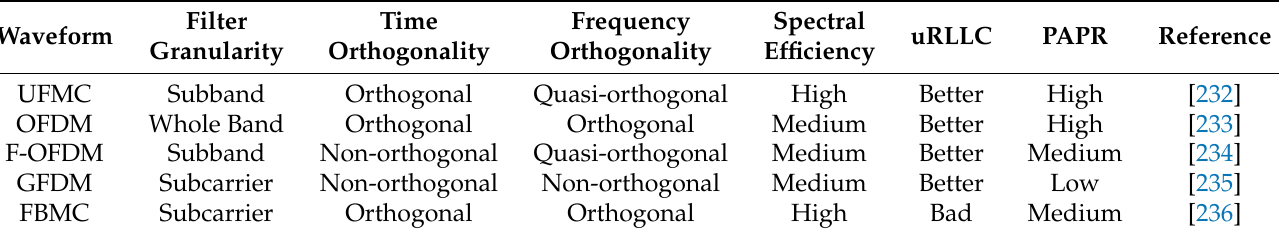
Table 7. Comparison between 5G waveform